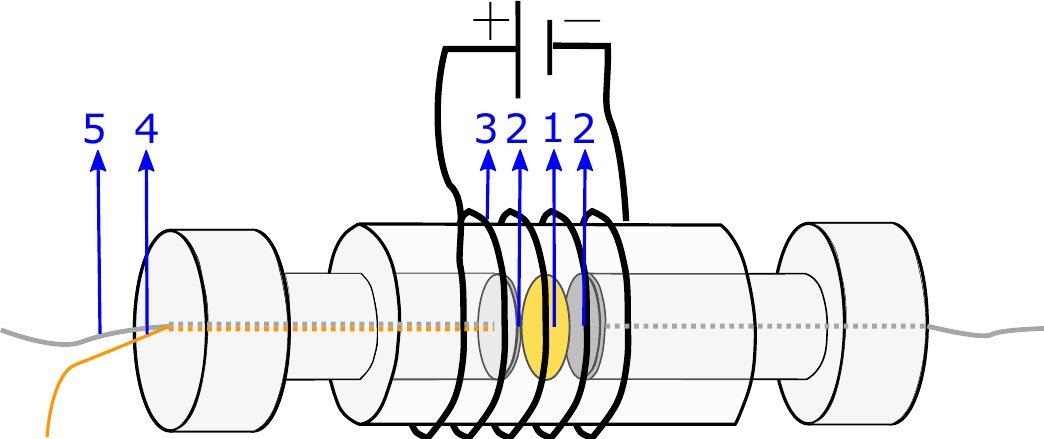
Figure 9. Sketch of the measurement cell for membrane conductivity, with (1) membrane sample(s), (2) platinum plates, (3) heating wire, (4) end of the thermocouple emerging from the cell, (5) end of the platinum wire (attached to the platinum plate) emerging from the cell.